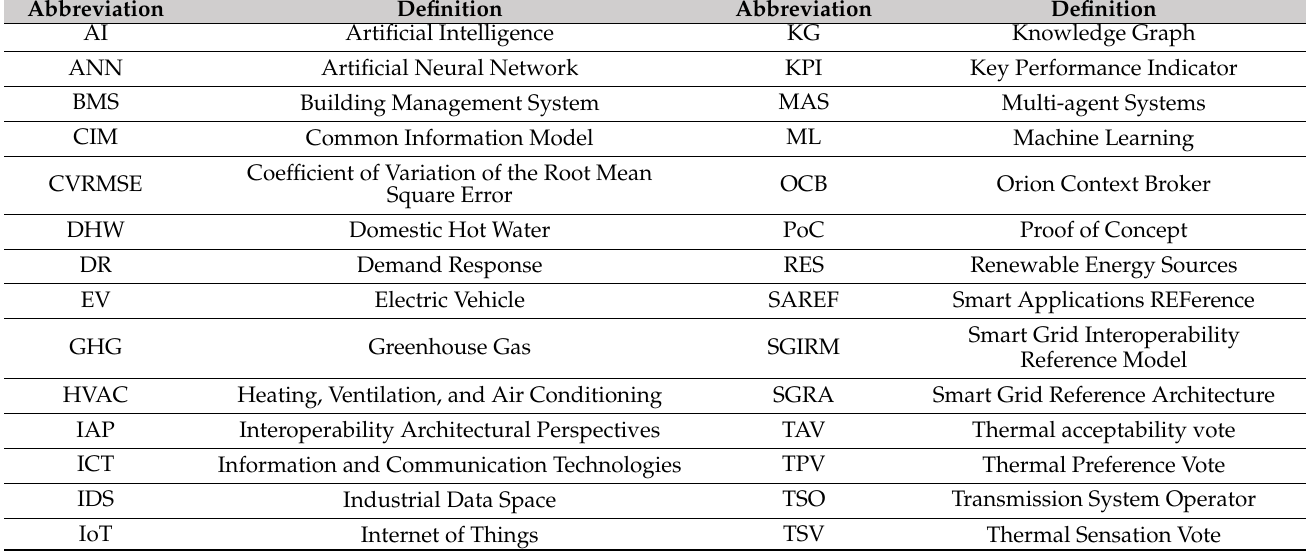
Table 1. List of abbreviations used in the